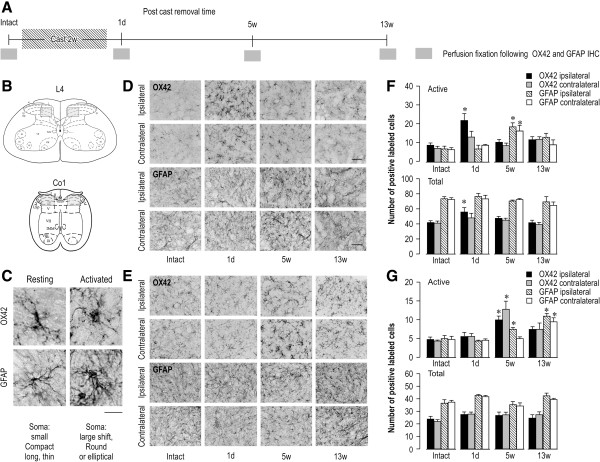
Glial cell activation spread beyond the immobilized hindlimb. (A) Schematic time-line for fixation and immunohistochemistry (1 d: 1 day, w: weeks). (B) Schematic illustration of the spinal cord segments, 4th lumbar (L4) and 1st coccygeal (Co1). Predefined square areas including lamina II–IV designate the area of quantitative analysis of microglia and astrocyte activation. (C) Glial staining indicating glial activation. Quantitative analysis was performed by a blindfolded independent observer using a counter. Scale bar = 20 μm. (D, E) Temporal patterns of glial cells in L4 (D) and Co1 (E) using OX42 and GFAP staining. Scale bar = 50 μm. (F, G) Number of positive labeled glial cells with OX42 and GFAP staining in L4 (F) and Co1 (G) segments. Upper graph shows the number of positive labeled activated glial cells; lower graph shows the total number of positive labeled glial cells. Results shown are the mean ± SEM (n = 4–6). *p < 0.05 compared with the intact group (one-way ANOVA followed by Dunnett’s post hoc test).